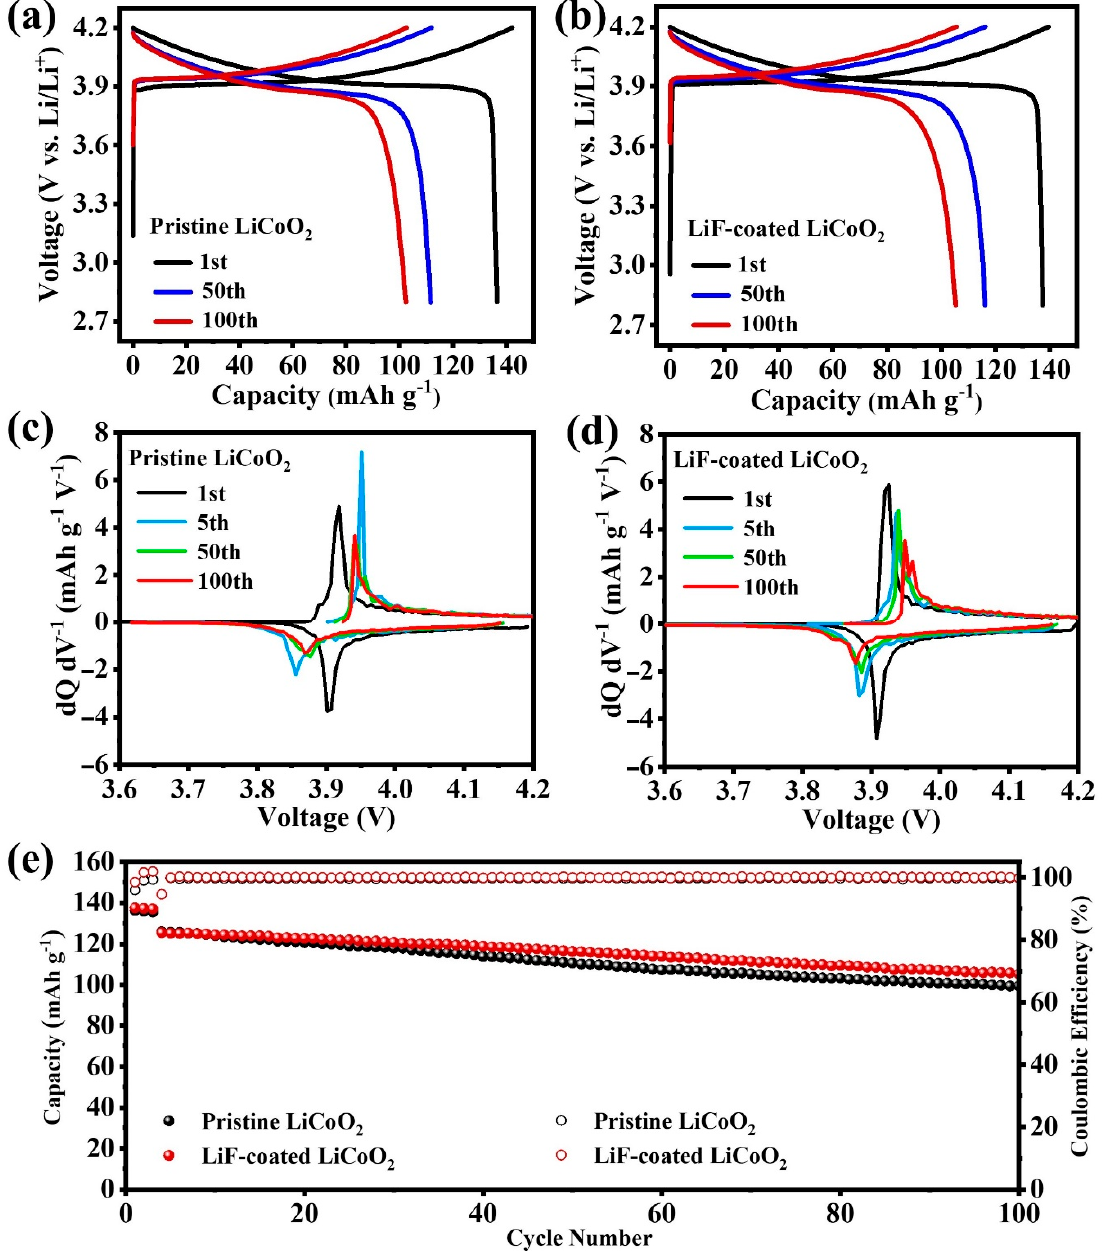
Figure 2. ( a , b ) Charge/Discharge curves, ( c , d ) differential capacity plots, ( e ) cycling performance and corresponding Coulombic efficiencies of pristine LCO and LiF-coated LCO.